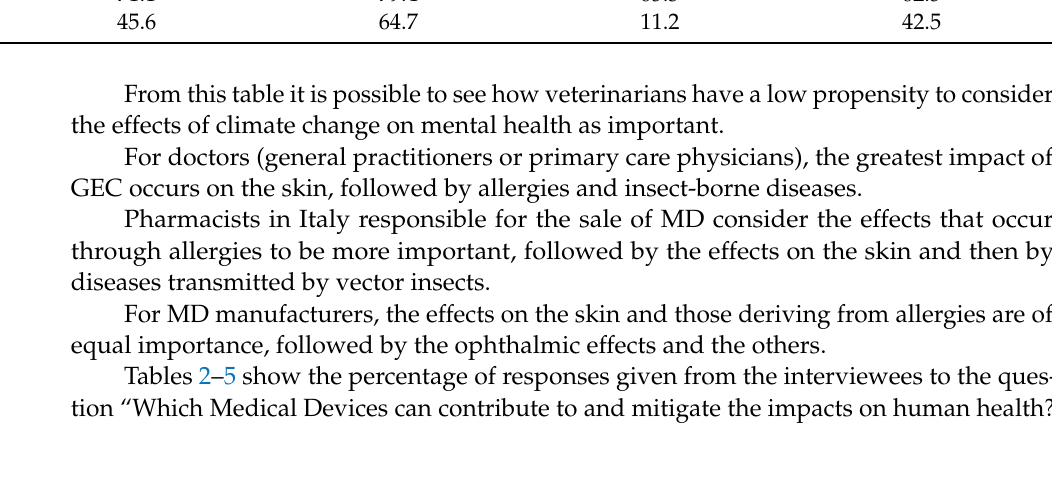
Table 1. Percentage of reply given to question about potential effects on human health caused by GEC.